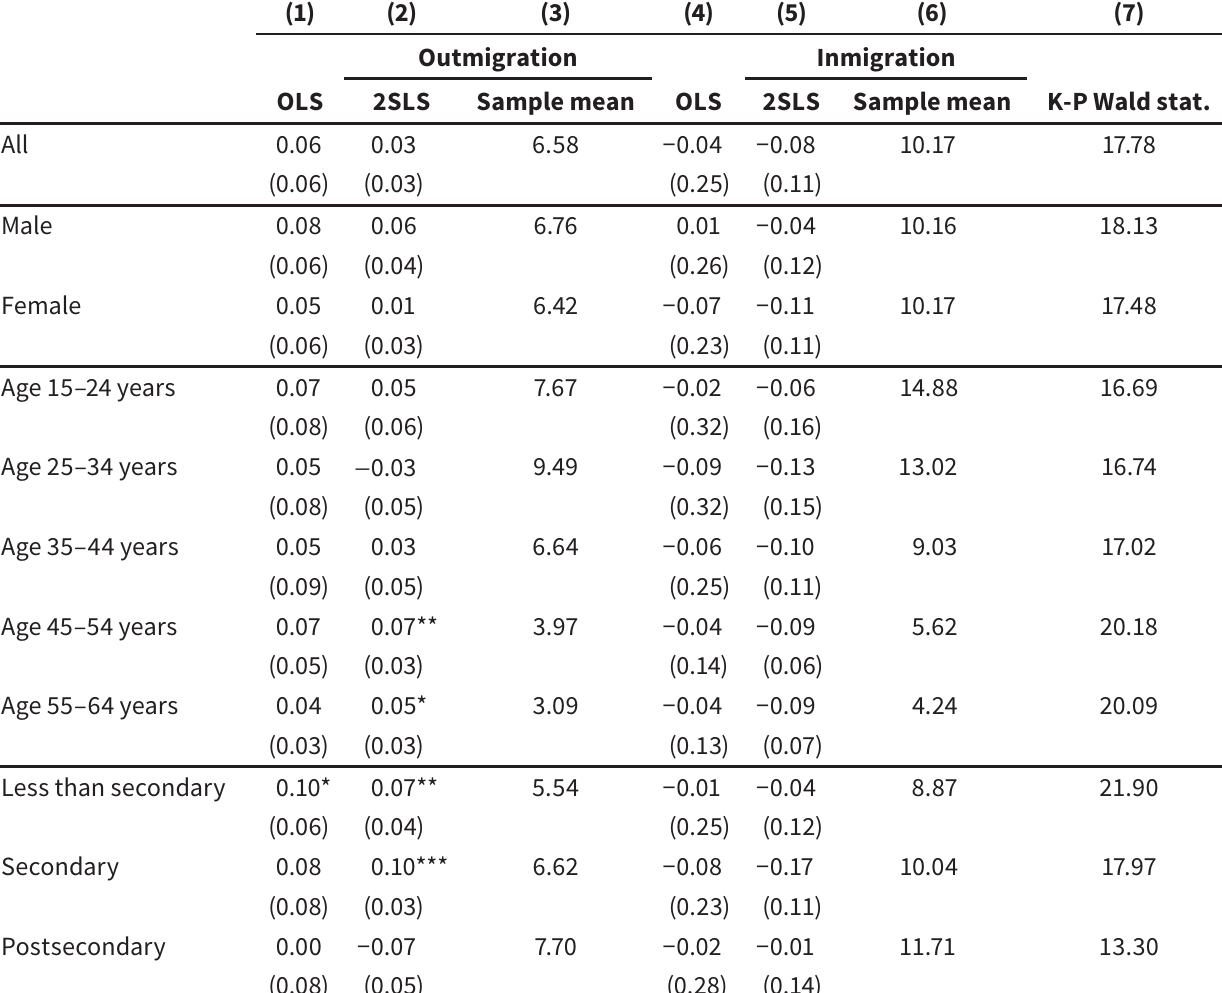
Effects on native internal